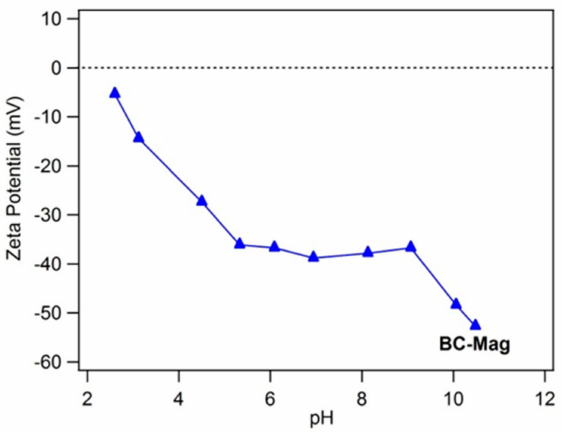
Figure 7. Zeta potential of black carbon magnetite. Experimental conditions for a: 0.1 g L − 1 graphene in 5 mM NaCl.